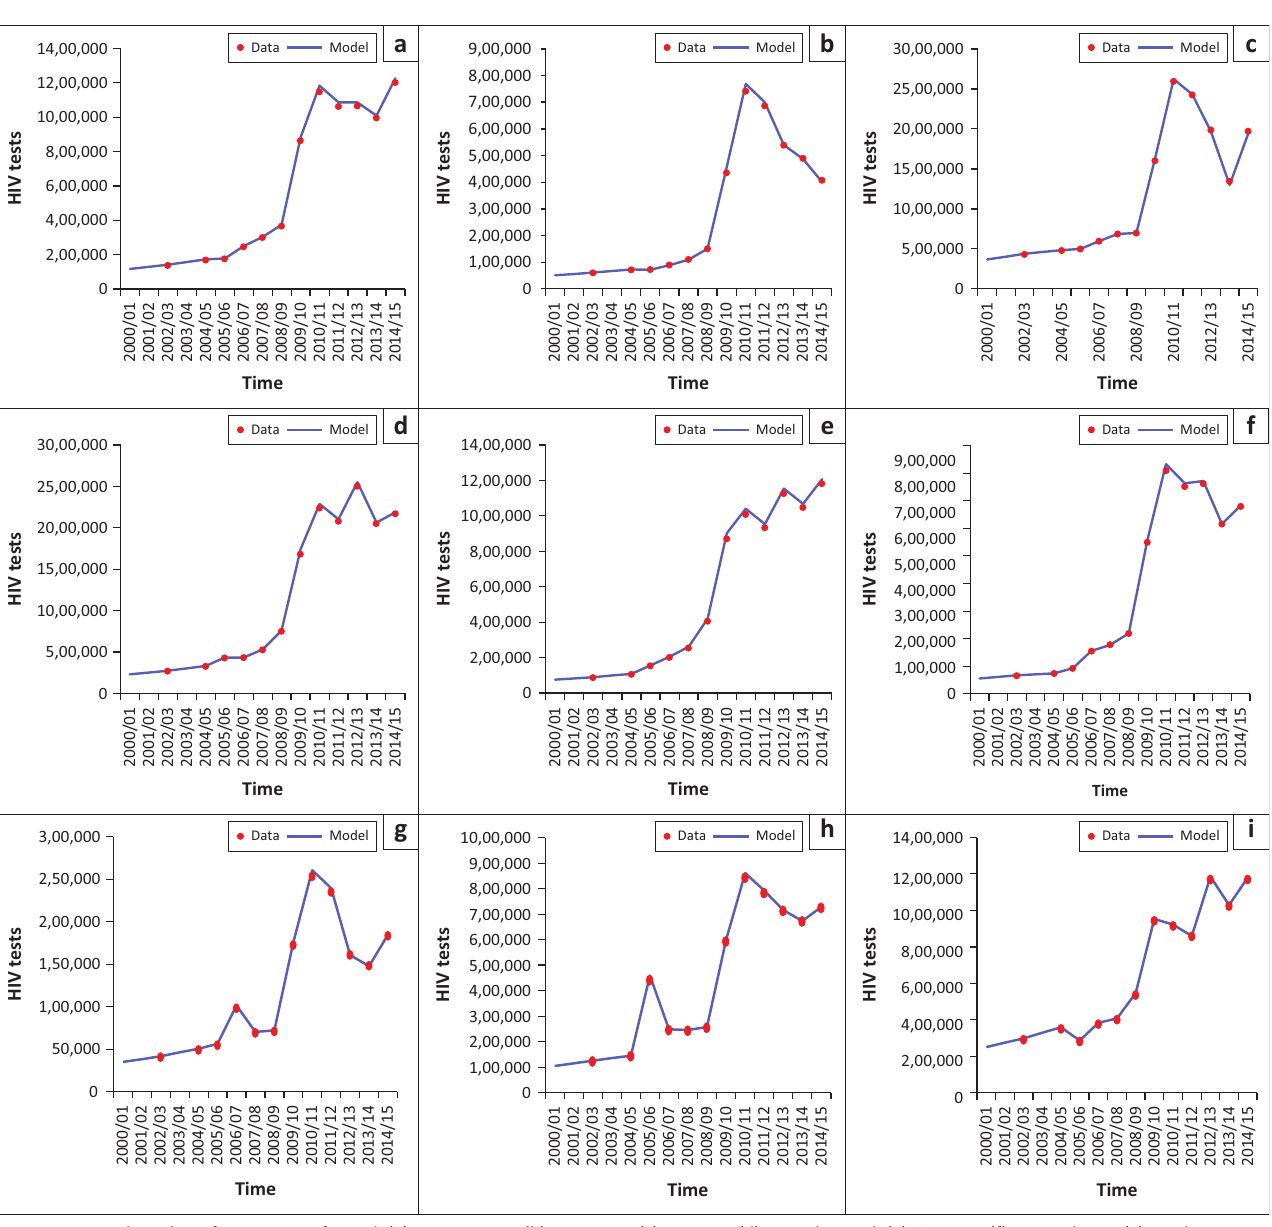
FIGURE 4: Annual number of HIV tests performed: (a) Eastern Cape; (b) Free State; (c) Gauteng; (d) KwaZulu-Natal; (e) Limpopo; (f) Mpumalanga; (g) Northern Cape; (h) North West; (i) Western